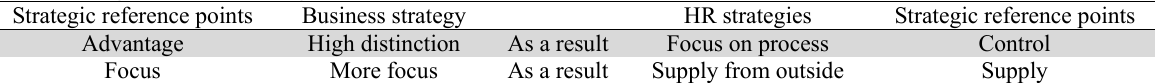
Basis of alignment in strategies based on distinction and focus Strategic reference points Business strategy HR strategies Strategic reference points Advantage High distinction As a result Focus on process Control Focus More focus Supply